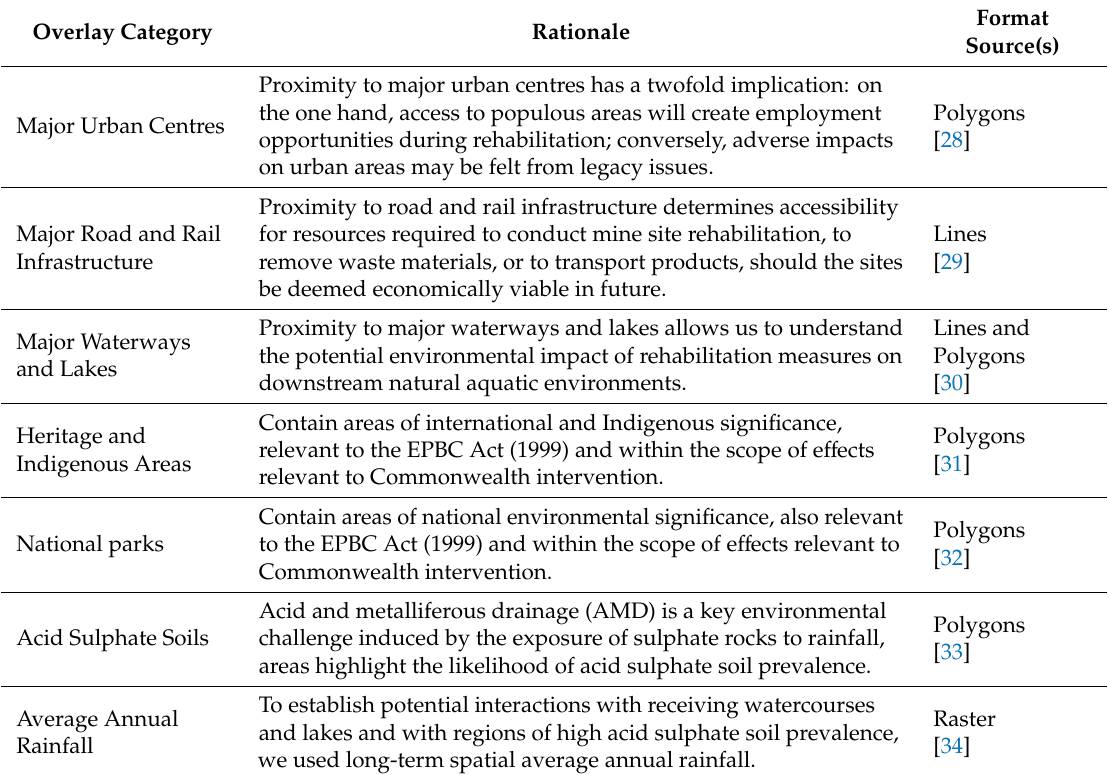
Table 2. Spatial overlays assessed against inactive mine